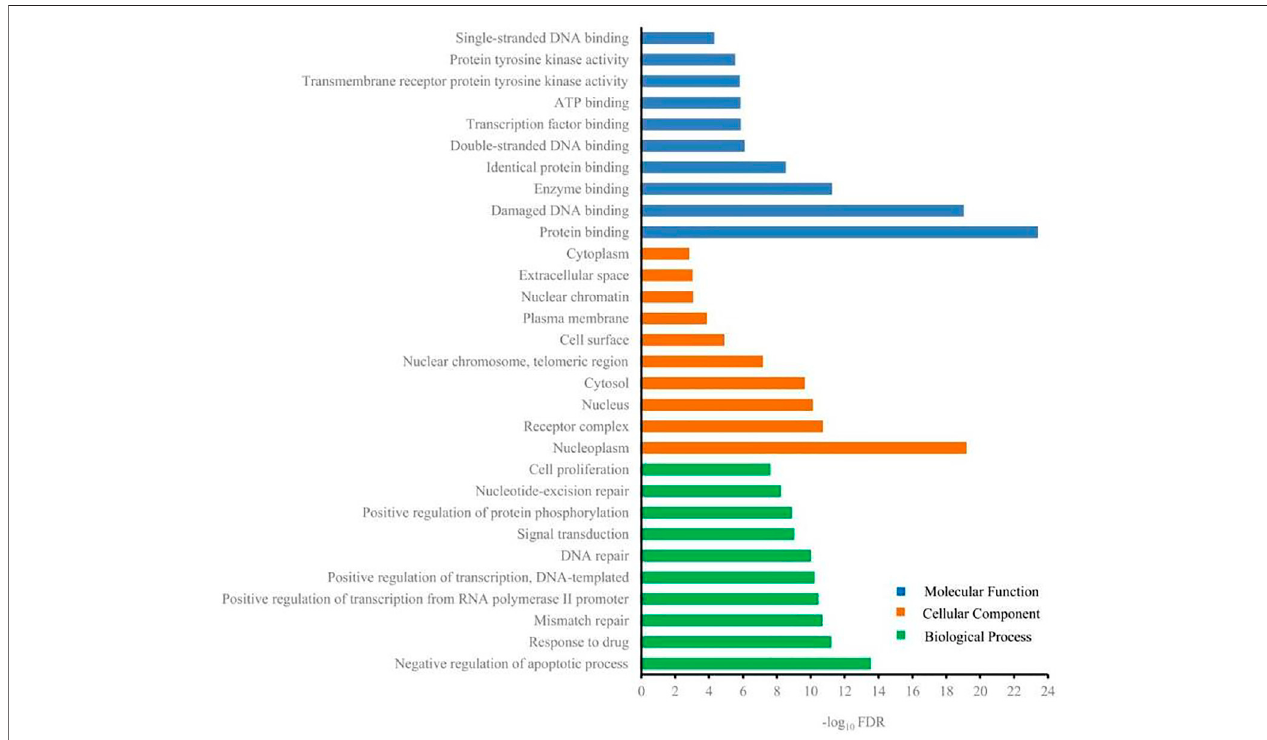
FIGURE 4 | Gene ontology terms of candidate targets for G-Rh2 in lung